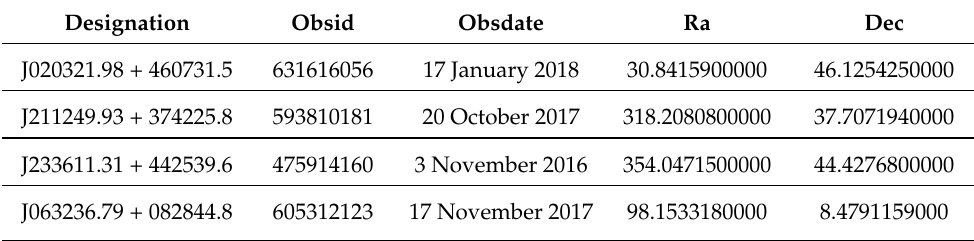
Table 5. List of new CV